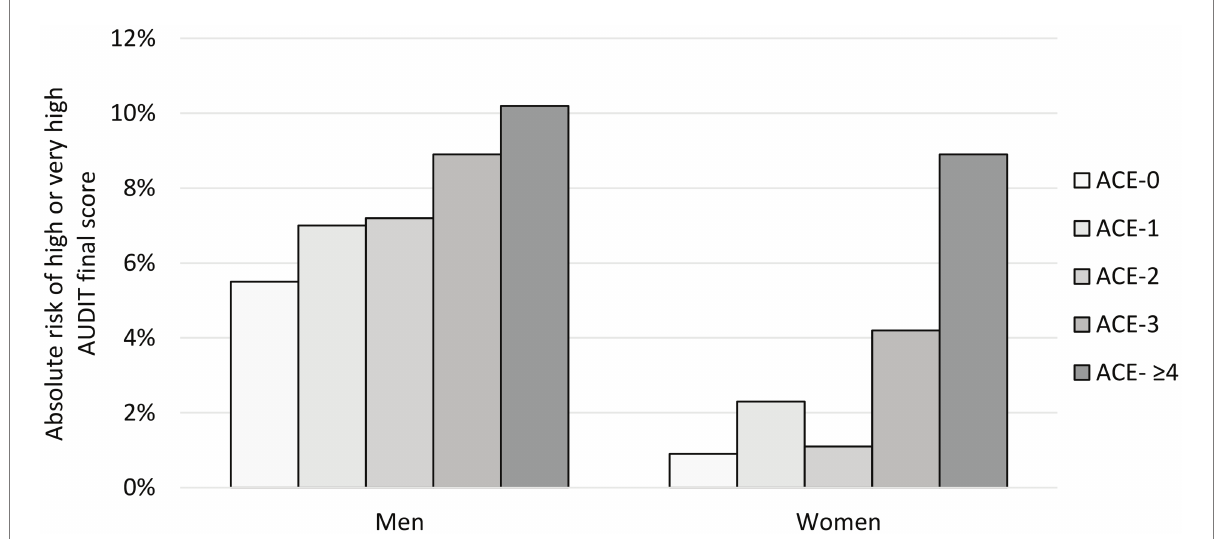
FIGURE 2 Absolute risk of high or very high AUDIT score in relation to ACE score, separately for men and women.